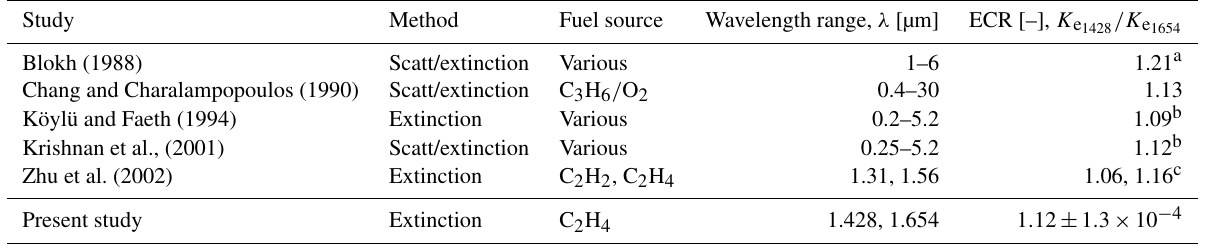
Table A1. Summary of black carbon extinction coefficient measurements with extinction coefficient ratios (ECRs) calculated for the wave- lengths selected for